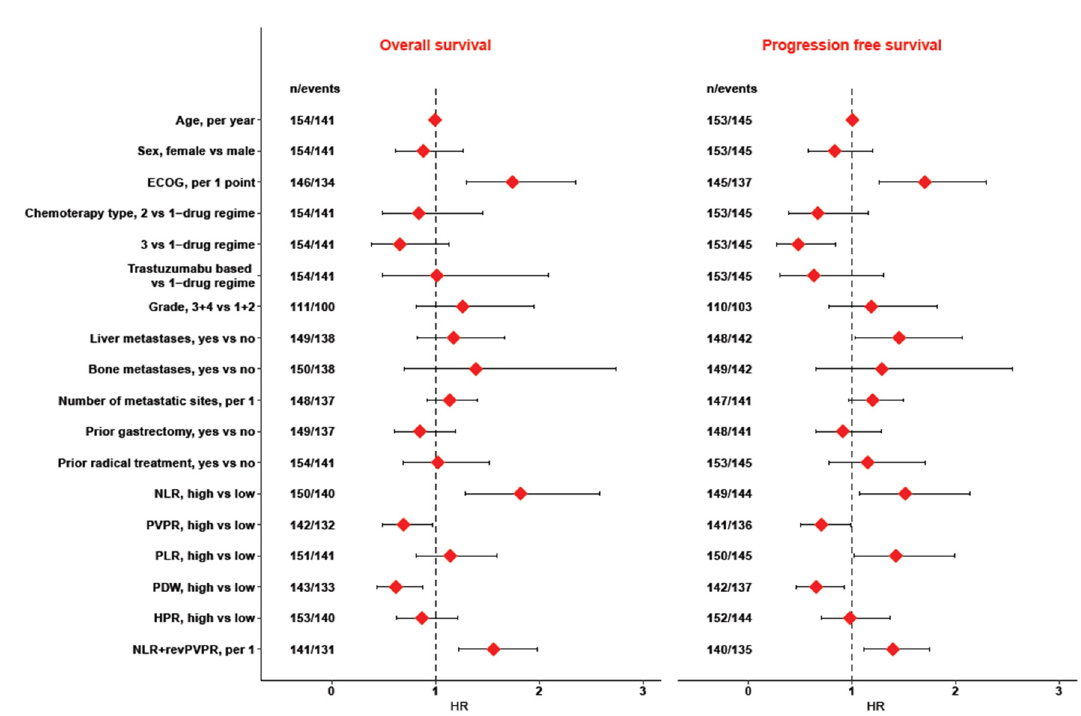
Figure 1. Univariable Cox regression.